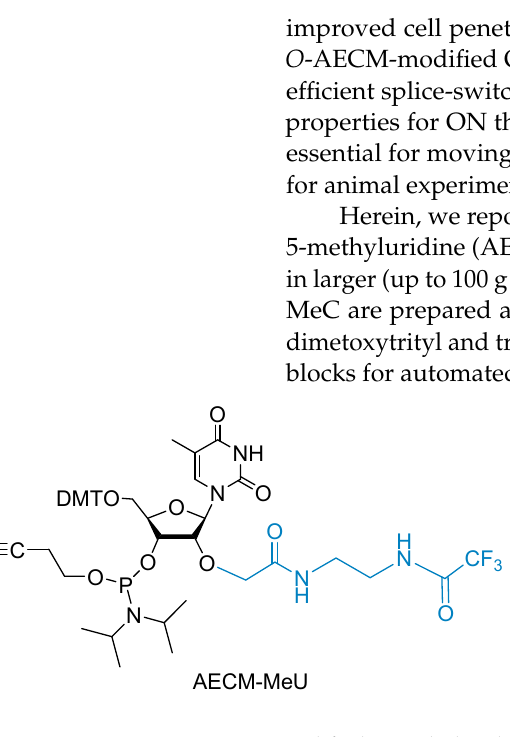
Figure 1. 2’-O-AECM modified 5-methyluridine (AECM-MeU) and 5-methylcytidine (AECM-MeC) nucleosides. 5-Methylated AECM-modified uridine and cytidine phosphoramidites ( Error! Ref-